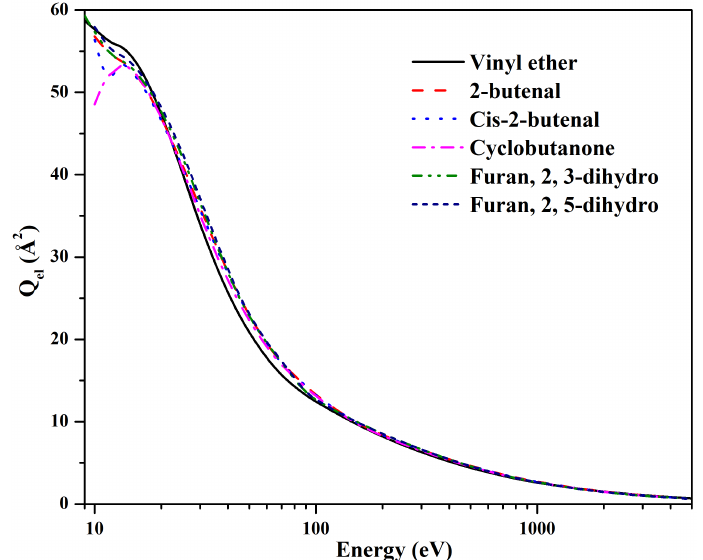
Figure 8. Q el for vinyl ether and its isomers. Solid line: present Q el for vinyl ether; dash line: present Q el for 2-butenal; dotted line: present Q el for cis-2-butenal; dash-dot line: present Q el for cyclobutanone; dash-dot-dot line: present Q el for furan, 2, 3-dihydro; short dash line: present Q el for furan, 2, 5-dihydro.